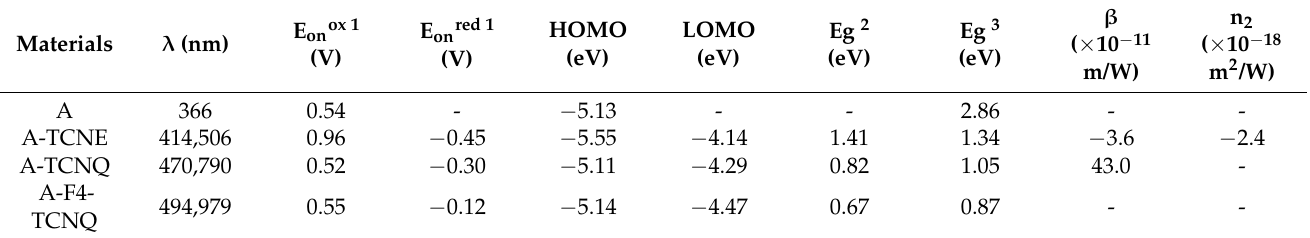
Table 1. Optical and electrochemical properties of the